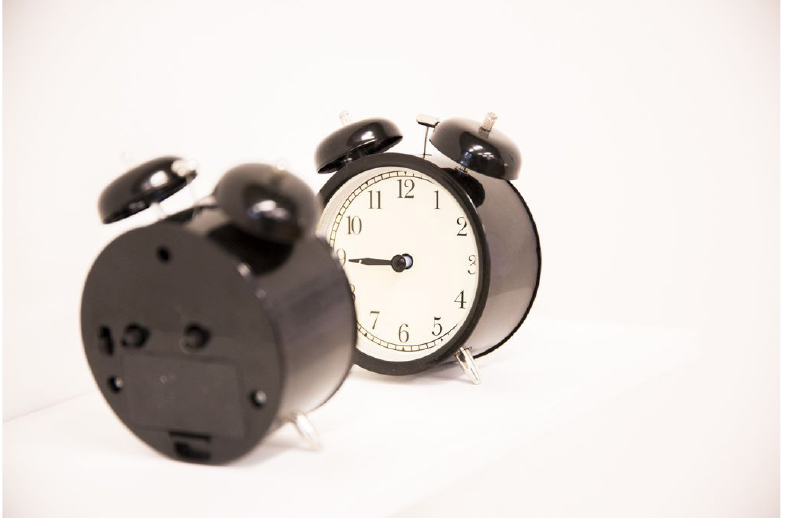
Figure 5: Roy Ananda, The Bodkin Experiments (detail), 2015, found objects, mixed media, dimensions variable. Photo: Kris- tina Shapranova. Courtesy the artist and Dianne Tanzer Gallery +